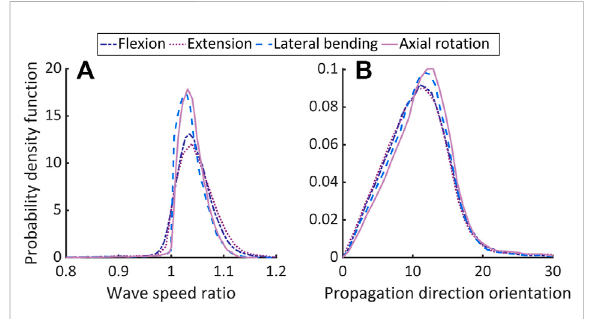
FIGURE 4 Comparing the theoretically predicted and approximated longitudinal wave speeds in non-degenerated AF. Plot (A) shows the ratio of wave speeds from Eq. 10 and the maximum from the directions in M and plot (B) shows the angular separation between the corresponding propagation directions, both expressed as probability density functions. (cid:1) μ and SD, respectively, range in (1.033 – 1.038), (0.0281 – 0.0510) for (A) , and (10.56 – 11.12),